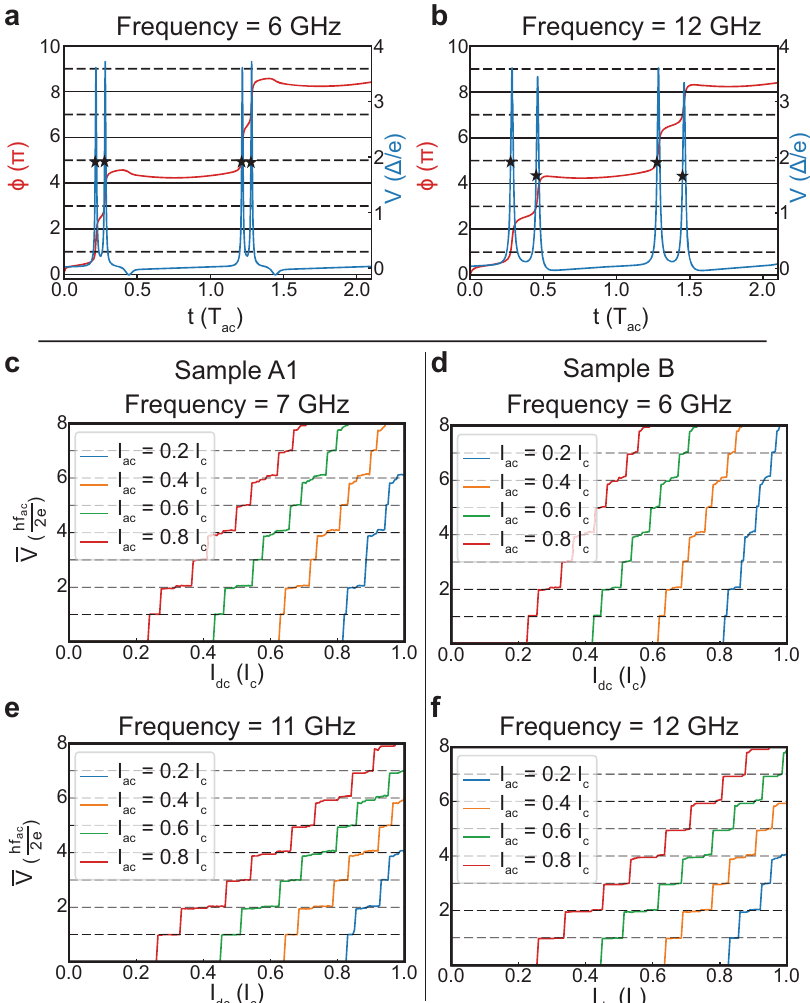
Fig. 4 Resistively shunted junction (RSJ) simulation accounting for LZTs. a , b Phase and the instantaneous voltage across the JJ. The parameters of sample B are used with τ = 0.98 and n = 0.97. The driving currents are I d.c. = 0.7 I c at 6 GHz and 0.8 I c at 12 GHz, and I a.c. = 0.4 I c at both frequencies, which corresponds to the second Shapiro step. The black stars indicate the instantaneous voltage at ϕ = π used in the calculation of the Landau – Zener transition. c , e V – I d.c. , curves showing Shapiro steps at 7 and 11 GHz for the parameters of device A1, with τ = 0.98 and n = 0.95. d , f V – I d.c. curves showing Shapiro steps at 6 and 12 GHz for the parameters of device B, with τ = 0.98 and n =